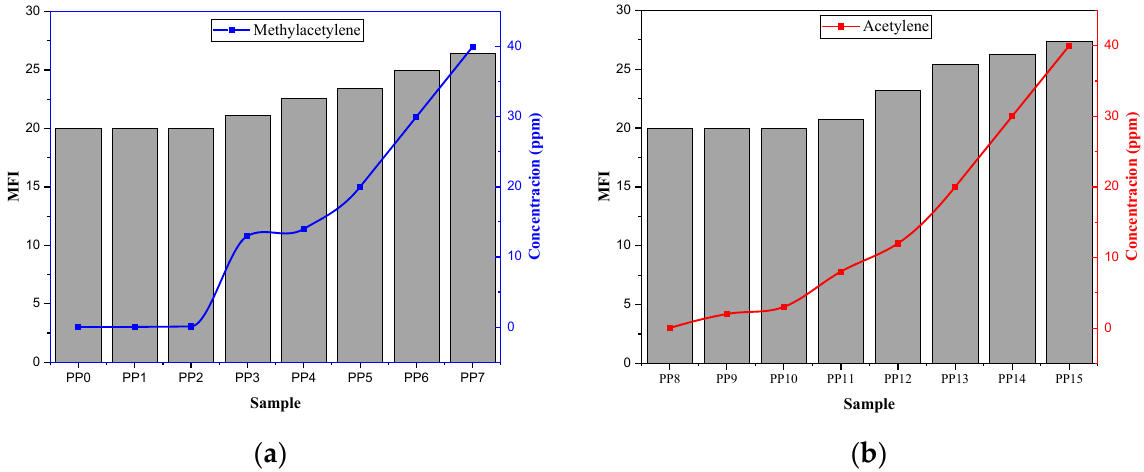
Figure 2. Variation of the MFI with respect to the concentration of impurities: ( a ) methyl acetylene and ( b ) acetylene.